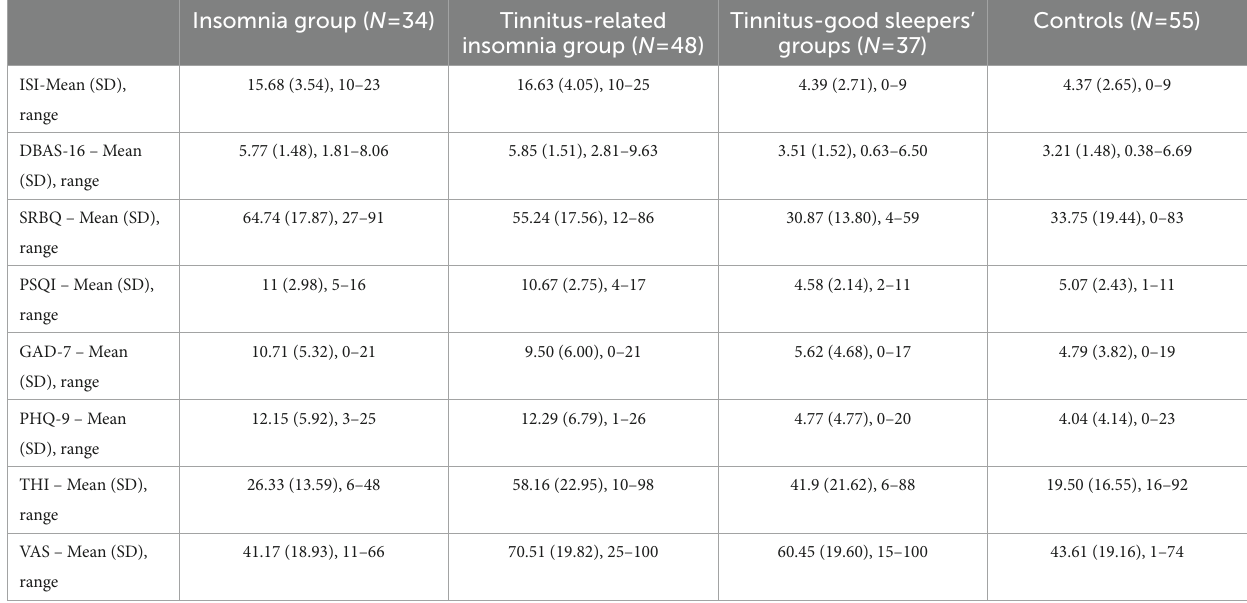
TABLE 2 Summary of measures completed across groups in a study exploring cognitive–behavioral factors in tinnitus-related